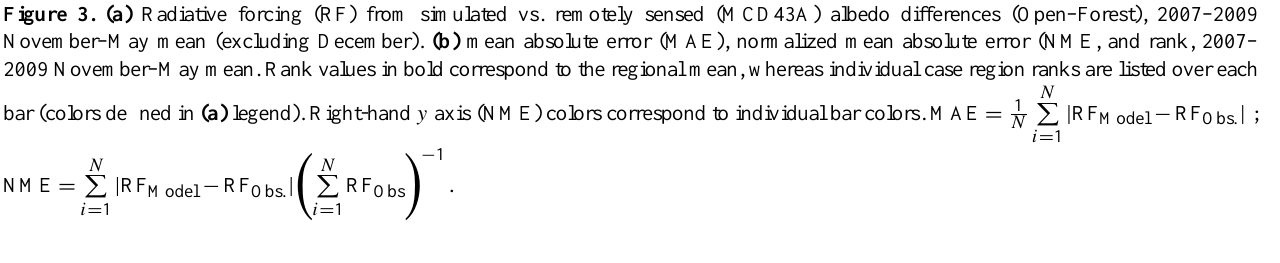
N P | RF | ; − RF Model Obs . N i = 1